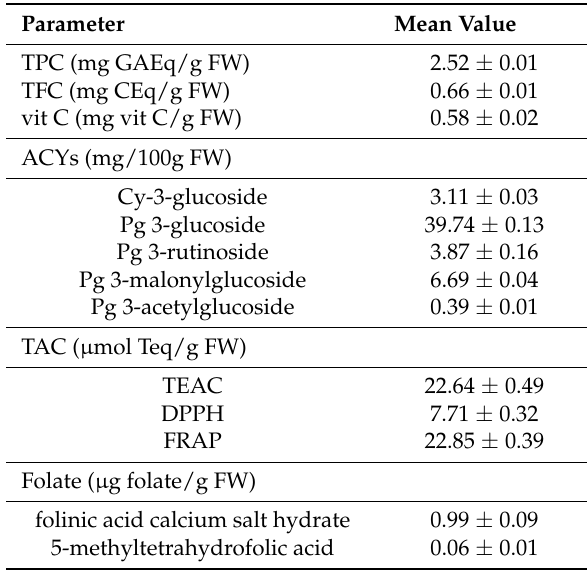
Table 1. Phenolic content and antioxidant capacity of Alba strawberry extract. Data are presented as mean value ± SD. TPC, total polyphenols content; TFC, total flavonoids content; vit C, vitamin C; ACYs, anthocyanins; Cy-3-glucoside, cyanidin-3-glucoside; Pg 3-glucoside, pelargonidin 3-glucoside; Pg 3-rutinoside, pelargonidin 3-rutinoside; Pg 3-malonylglucoside, pelargonidin 3-malonylglucoside; Pg 3-acetylglucoside, pelargonidin 3-acetylglucoside; TAC, total antioxidant capacity; TEAC, Trolox Equivalent Antioxidant Capacity; DPPH, 2,2-DiPhenyl-1-PicrylHydrazyl and FRAP, Ferric Reducing Antioxidant